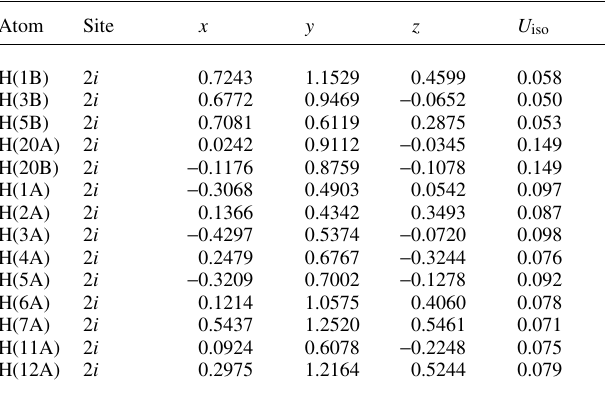
Table 2. Atomic coordinates and displacement parameters (in Å 2 )